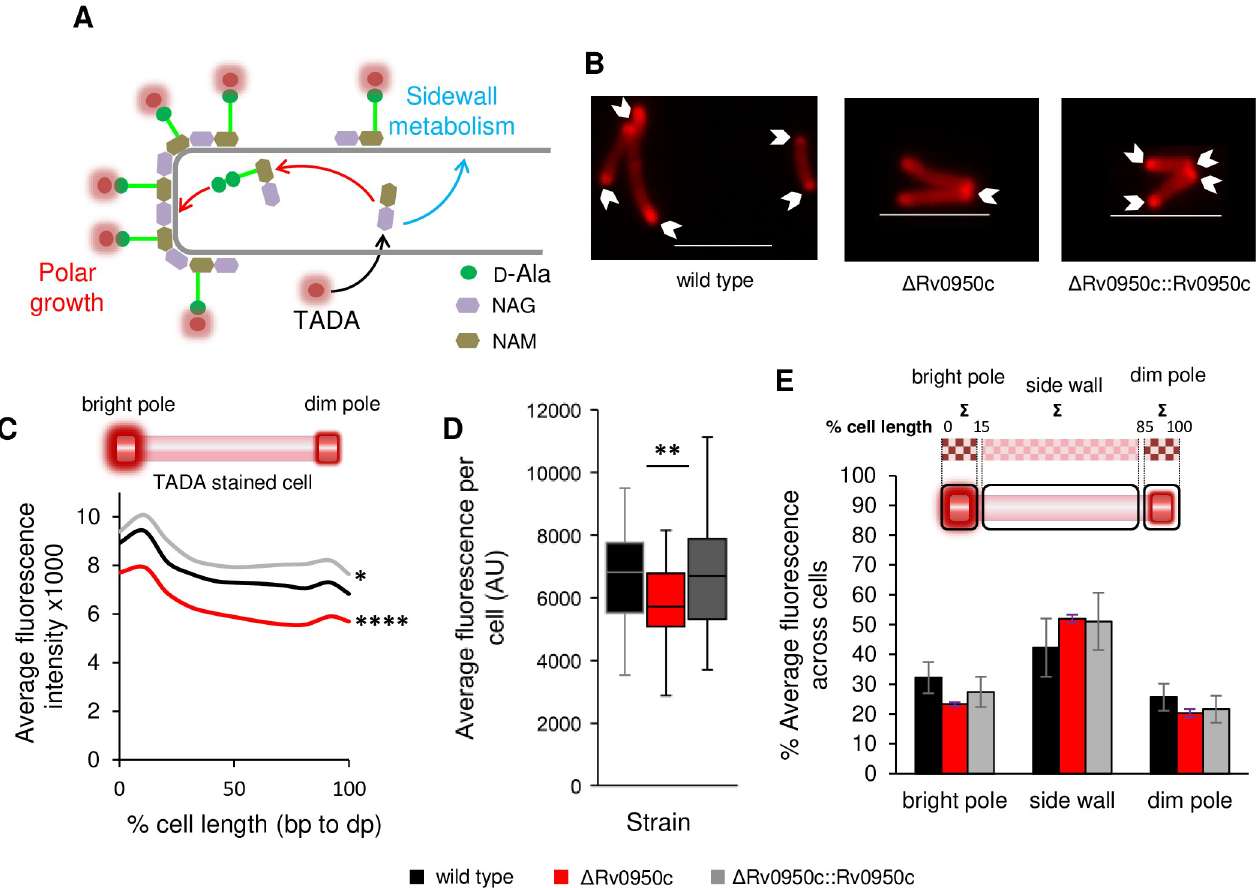
Fig 4. TADA incorporation in the Rv0950 deletion mutant. TADA incorporation was compared in M . tuberculosis wild type (WT, black), Δ Rv0950c (red) and Δ Rv0950c::Rv0950c (grey). A) Schematic diagram showing the mechanism of TADA incorporation reporting on polar growth (red) and side wall metabolism (turquoise), D-Ala: D-Alanine, NAG: N-acetylglucosamine, NAM: N -acetylmuramic acid. B) Representative fluorescence micrographs of stained cells. Scale bar = 5 μ m. C) Fluorescence intensity profiles of M . tuberculosis labelled with TADA. 0% represents the brightest pole. Graph shows average of fluorescence intensity measured at 10% intervals of the cell length. ���� p = 0.0008 and 4.09E -6 for mutant compared to wild type or complement respectively across the cell length. � p = 0.03 for wild type compared to complement. D) Average fluorescence intensity for each cell. �� p = 0.0029 and 0.0049 comparing mutant to wild type and complement respectively. p values obtained by single factor ANOVA in Excel for three biological replicates. E) Average distribution of fluorescence between the bright pole (sum of fluorescence across the first 15% of the cell length), the side wall (sum of fluorescence between 16–84% of the cell length) and dim pole (sum of fluorescence from 85–100% of the cell